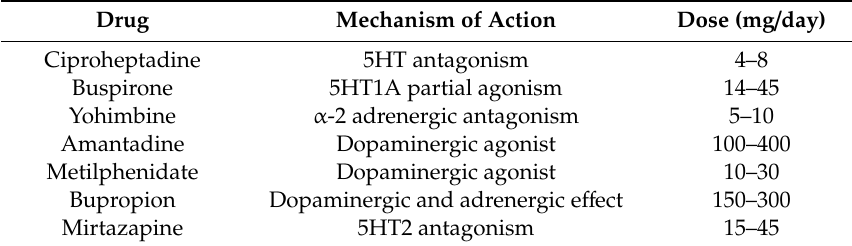
Table 3. Add-on treatments for antidepressant-induced anorgasmia [77–84]. Drug Mechanism of Action Dose (mg / day) Ciproheptadine 5HT antagonism 4–8 Buspirone 5HT1A partial agonism